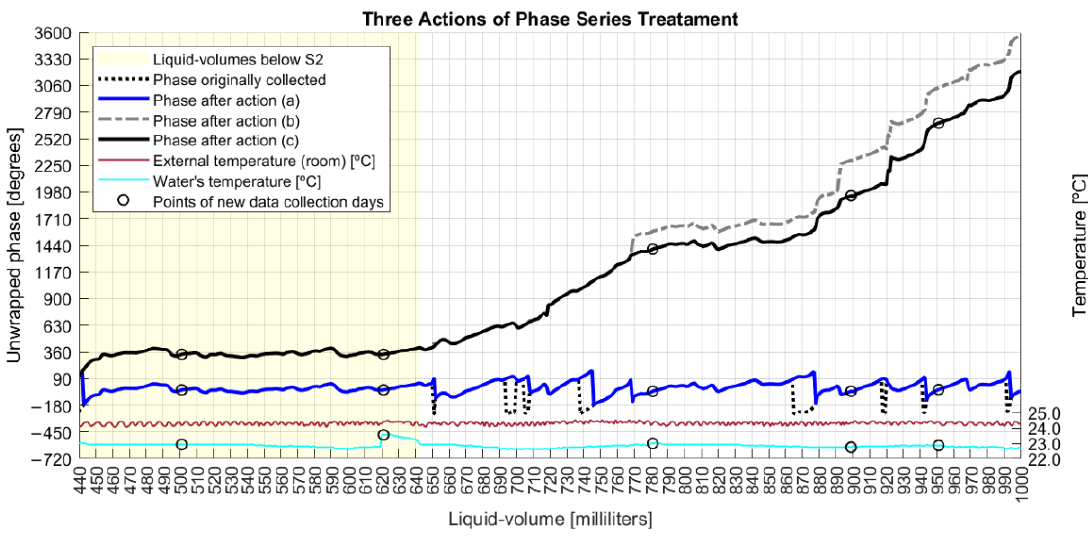
Figure 11. Three actions of phase series adjustments.